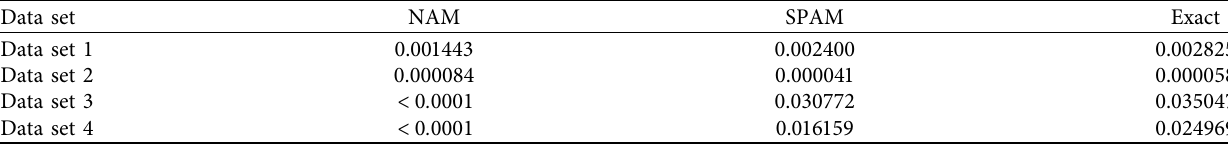
Table 1: P values for tumorigenicity and bladder tumor